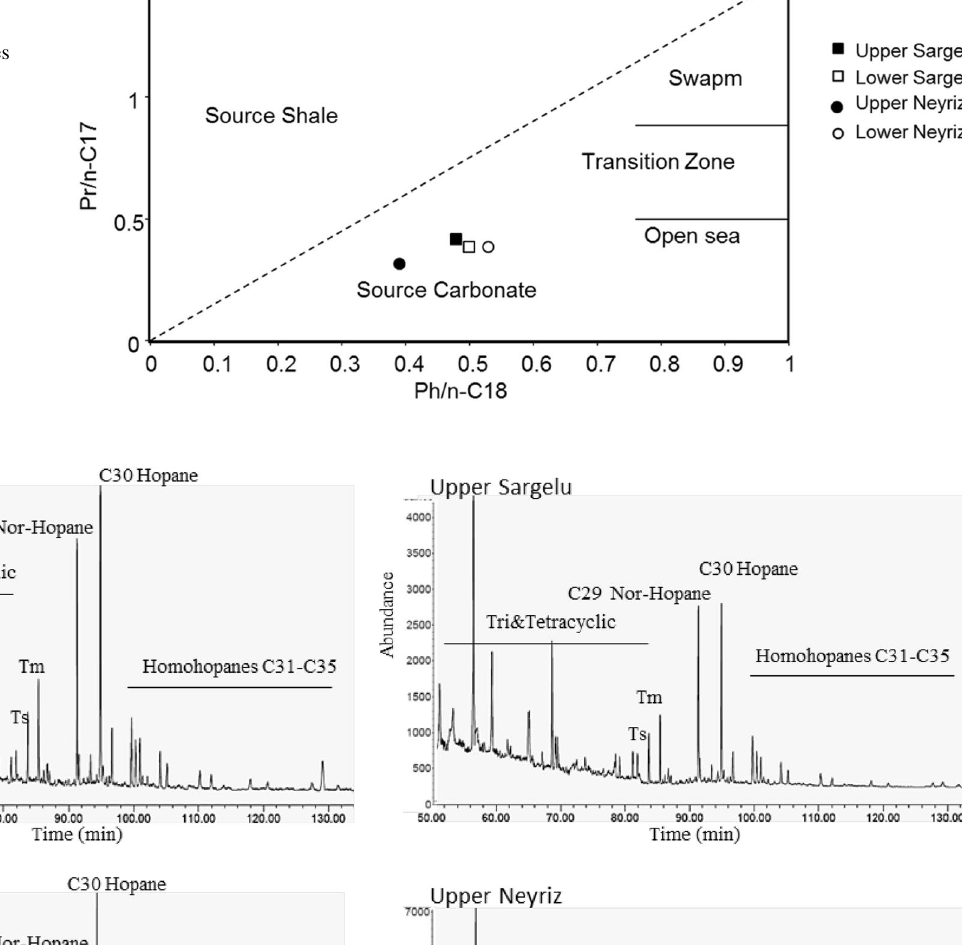
Fig. 8 Pristane Pr/n-C17 vs. phytane Ph/n-C18, showing depositional environment and lithology of organic-rich zones (diagram from Mathur et al.